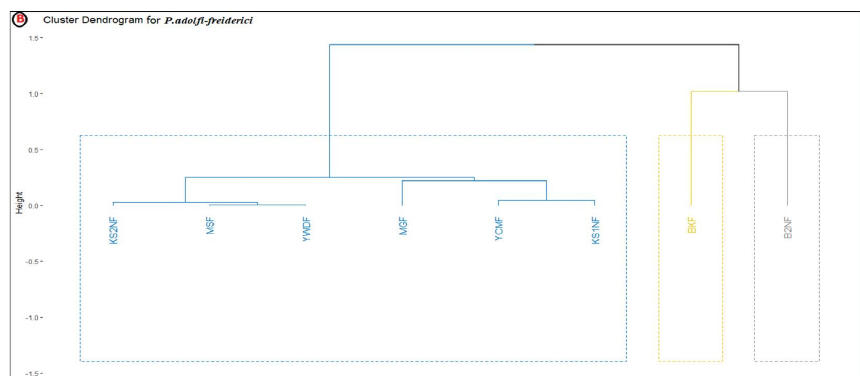
Figure 4: Hierarchical clustering of the populations of P. adolf-freiderici based on one scaled morphometric data using “Euclidean” distance and “wards D2” method. YCMF � Yayu cofee mixed forest, KS1NF � Kafa-Shera 1 natural forest, KS2NF � Kafa-Shera 2 natural forest, MGF � Masha-Gorashewi forest, MSF � Masha-Sherach forest, YWDF � Yayu-Wabu Dureni forest, BKF � Bebeka-Kebereta forest, and B2NF � Bebeka 2-natural forest.